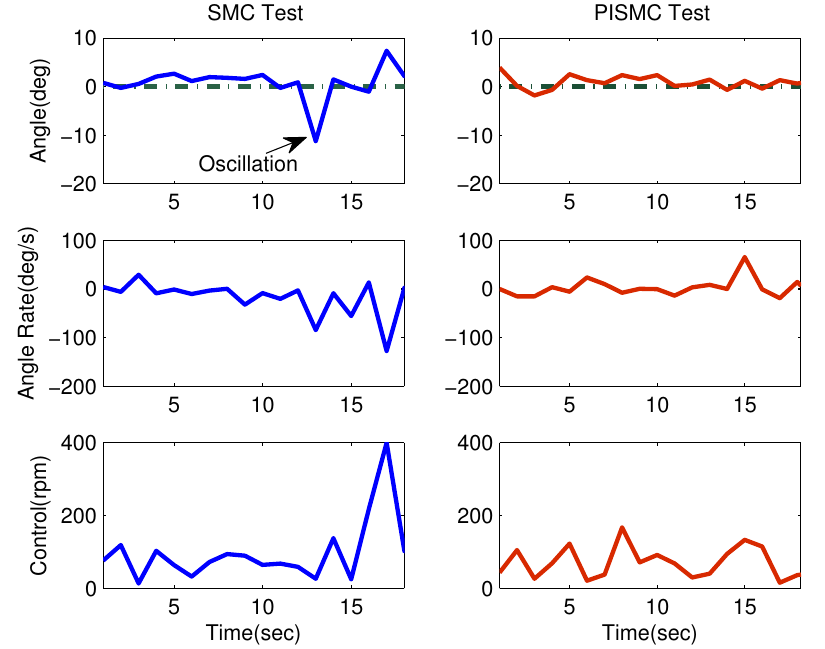
Figure 16. Experimental results of TWVS with disturbances: ( left ) SMC is implemented; ( right ) PISMC is